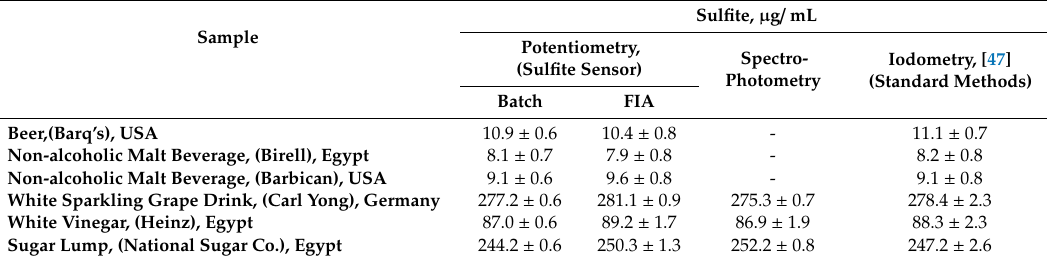
Table 2. Determination of sulfite in some beverage samples using potentiometry with the sulfite sensor under batch and FIA modes of operation, spectrophotometry with cobalt phthalocyanine and the standard iodometric